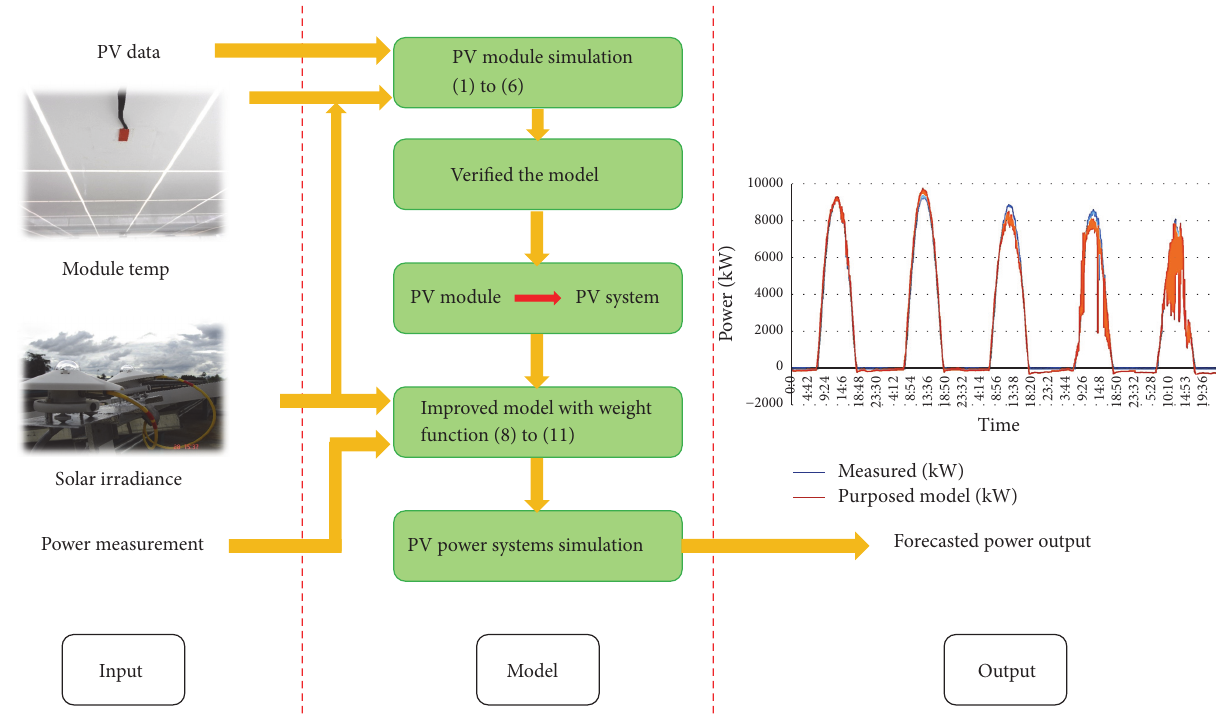
Figure 2: Structure of PV system simulation model.